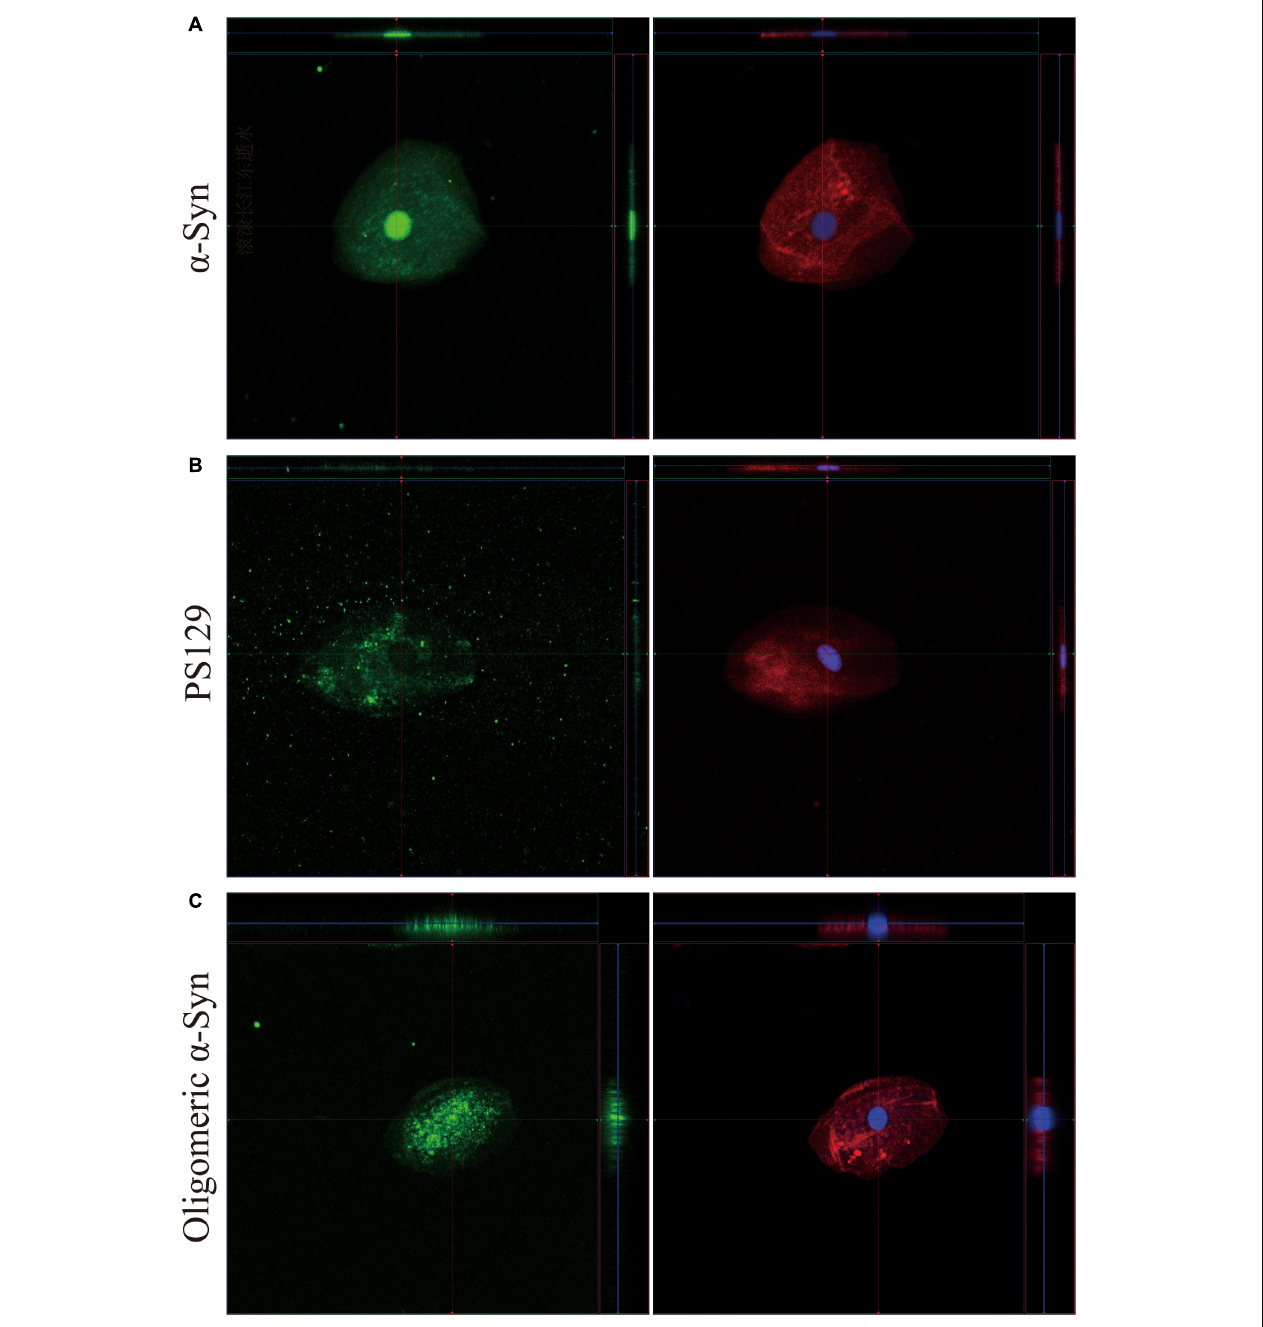
FIGURE 2 | 3D reconstruction of z-stack confocal images ( × 40). The first column shows α -Syn (A) , pS129 (B) , and oligomeric α -Syn (C) in green. The cytoskeleton stained with phalloidin (red) and nuclear stained with DAPI (blue) are shown in second column. α -Syn, α -synuclein; pS129, phosphorylated at Ser129.